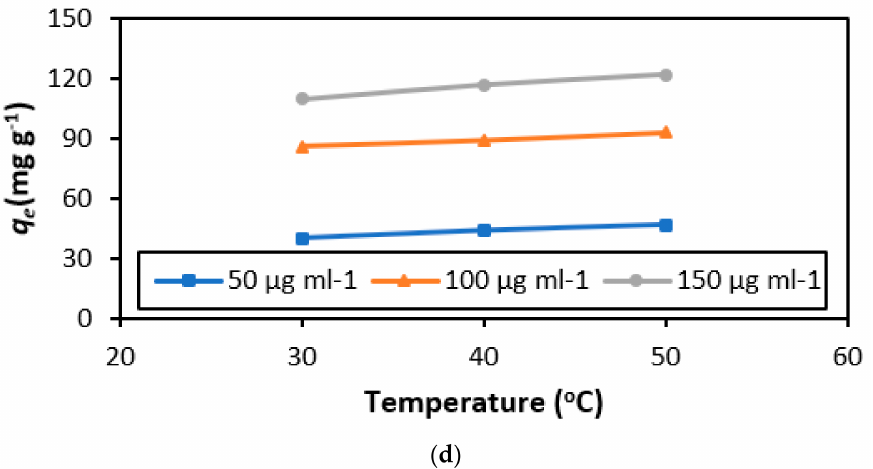
Figure 4. Effect of ( a ) the pH, ( b ) initial dye concentration, ( C o ) with percent removal efficiency, ( c ) adsorbent dosage, and ( d ) temperature of